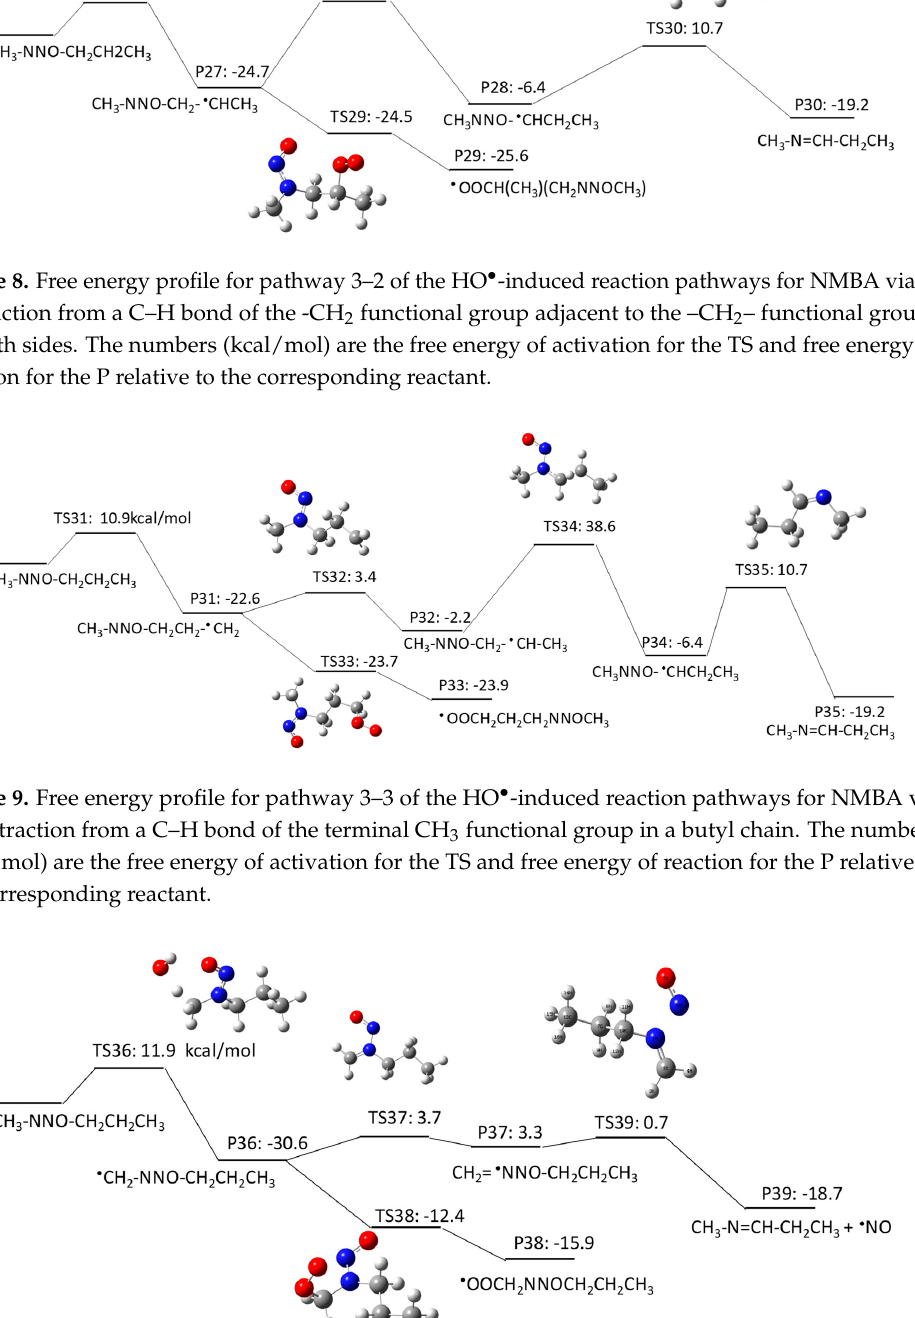
Figure 10. Free energy profile for pathway 3–4 of the HO • -induced reaction pathways for NMBA via H abstraction from a C–H bond of the terminal CH 3 functional group adjacent to the N–NO functional group. The numbers (kcal/mol) are the free energy of activation for the TS and free energy of reaction for the P relative to the corresponding reactant.